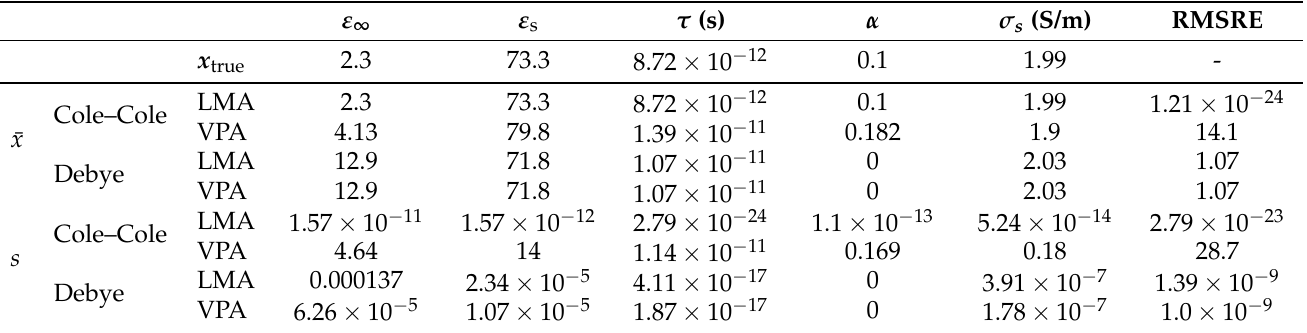
Table 5. Statistical diagnostics on fitting results. Set C of the initial points and 100 mg/dL glucose concentrations were